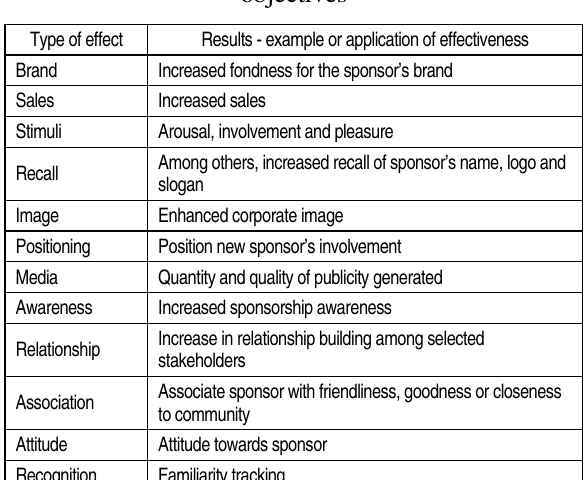
Table 1. Type of effect specified in